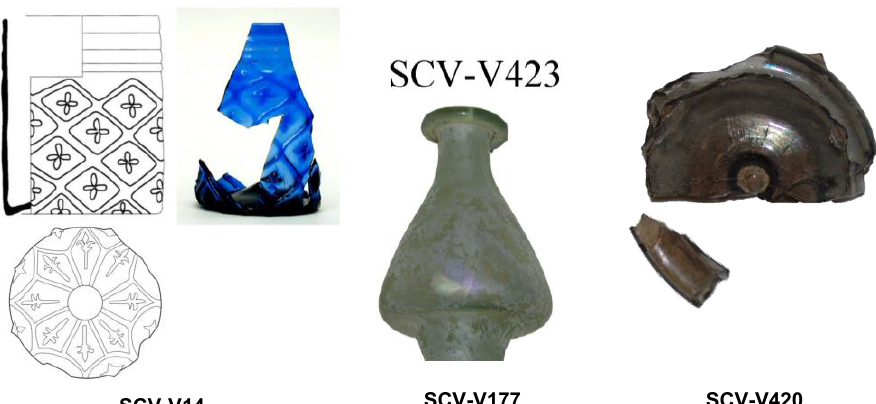
Figure 8. Santa Clara-a-Velha Monastery objects: SCV-V14 (photo and archaeological drawing by T. Medici ©) footless drinking cup (type 10.1) with a pattern of a four-petalled flower or cross enclosed in lozenges; SCV-V177 (photo by I. Coutinho ©), a gourd-shaped vessel (type 2); and SCV-V420 (photo by I. Coutinho ©), a drinking glass with a foot and stem (type A.3) made from the same glass gather.